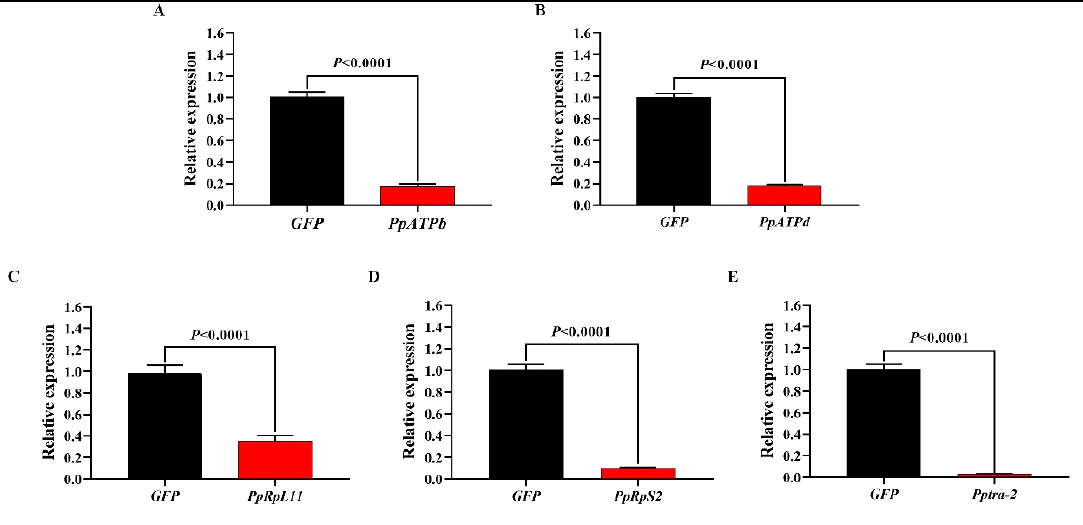
Figure 4. Relative expression of five genes ( A – E ) in Phytoseiulus persimilis when interfered or not. Total RNAs were extracted from 10–15 P. persimilis individuals. Four biological replicates were set for each gene. Differences of relative expression between target gene and GFP were analyzed with a t -test using IBM-SPSS 22.0 and all graphs were created using GraphPad Prism 8.0.